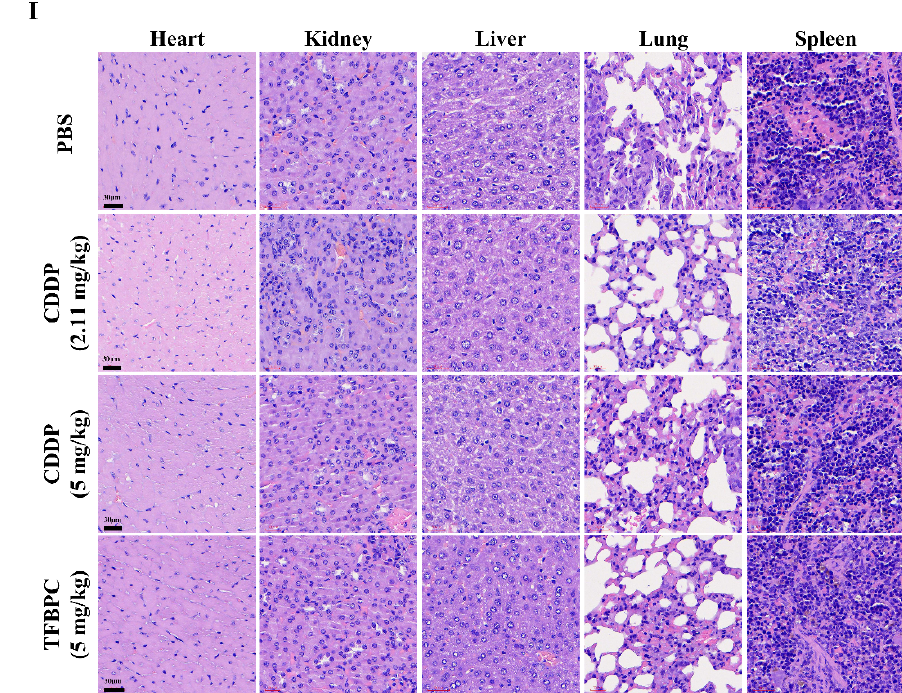
Figure 5. TFBPC significantly reduced tumor growth in the TNBC-bearing xenograft model and PDX model. NSG mice (N = 16 in each model) were subcutaneously implanted with MDA-MB-231 cells or patient-derived TNBC tumor tissues on the right flank or mammary gland. In the xenograft model ( A – C ), mice were intraperitoneally administrated with PBS (5 mL/kg), CDDP (2.11 mg/kg or 5 mg/kg) or TFBPC (5 mg/kg) once per week and sacrificed 28 days after the start of treatments. In the PDX model ( D – F ), mice were intravenously injected with PBS or platinum-containing agents once per week and sacrificed on day 23. Tumor growth curves and body weight were measured twice per week. Black arrows demonstrated the four times of drug administration. Tumors from xenograft and PDX models were harvested for photography ( B , E ) and weighed ( C , F ) to evaluate the compound-dependent anticancer effect. The representative images of PDX models ( G ) were obtained after sacrificing. Tumors ( H ) and organs ( I ) for immunohistochemistry staining of P53, Ki-67, cleaved caspase 3, PD-L1 and hematoxylin and eosin (HE) were harvested from the xenograft model, and all images were carried under 63 × magnification. Mean ± SD. * p < 0.05; ** p < 0.01; *** p < 0.001; **** p < 0.0001. Table 3. Parameters of cancer-bearing xenograft model.